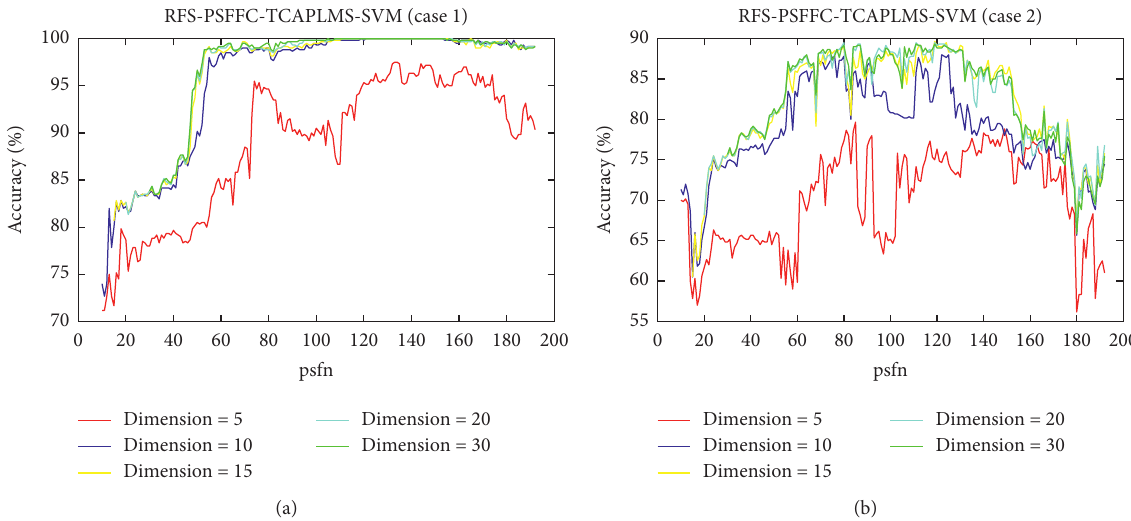
Figure 32: The testing accuracies of RFS-PSFFC-TCAPLMS-SVM with different dimension sizes for TCAPLMS.